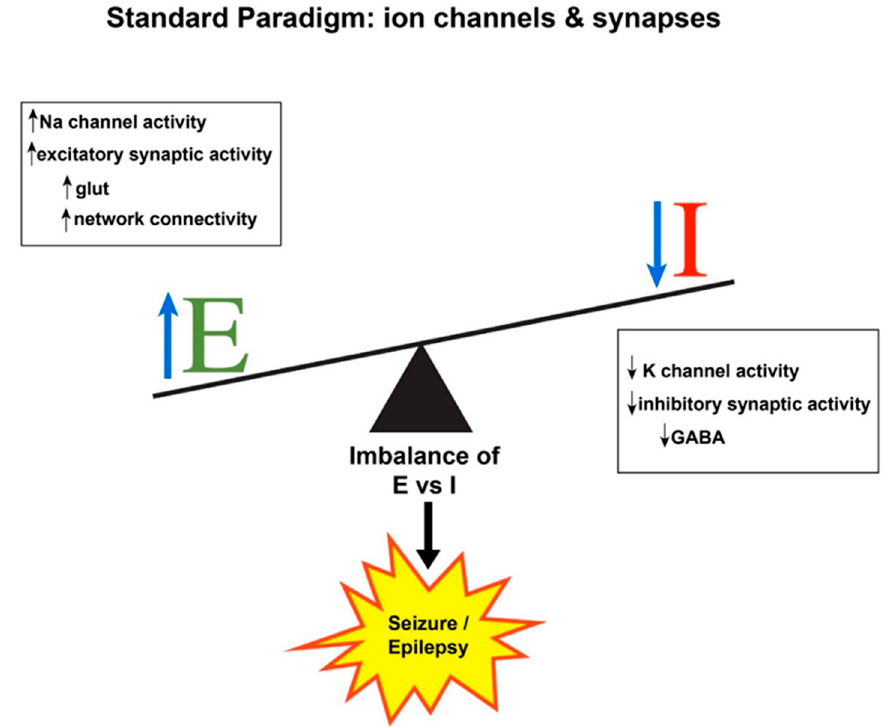
Figure 1. Schematic showing standard paradigm for understanding the balance between excitation (E) and inhibition (I) in the production of seizures and epilepsy. Any physiological change that increases E or decreases I (or both) will tip the balance toward excitation and possible seizure occurrence. GABA, gamma-aminobutyric acid; glut, glutamate; Na, sodium; K, potassium.